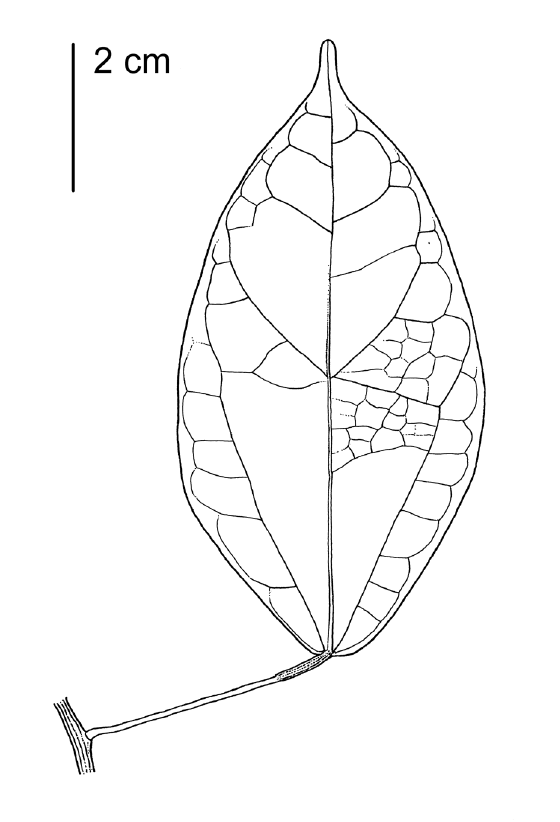
Figure 5 – Kolobopetalum ovatum : leaf. Drawn by Marjolein